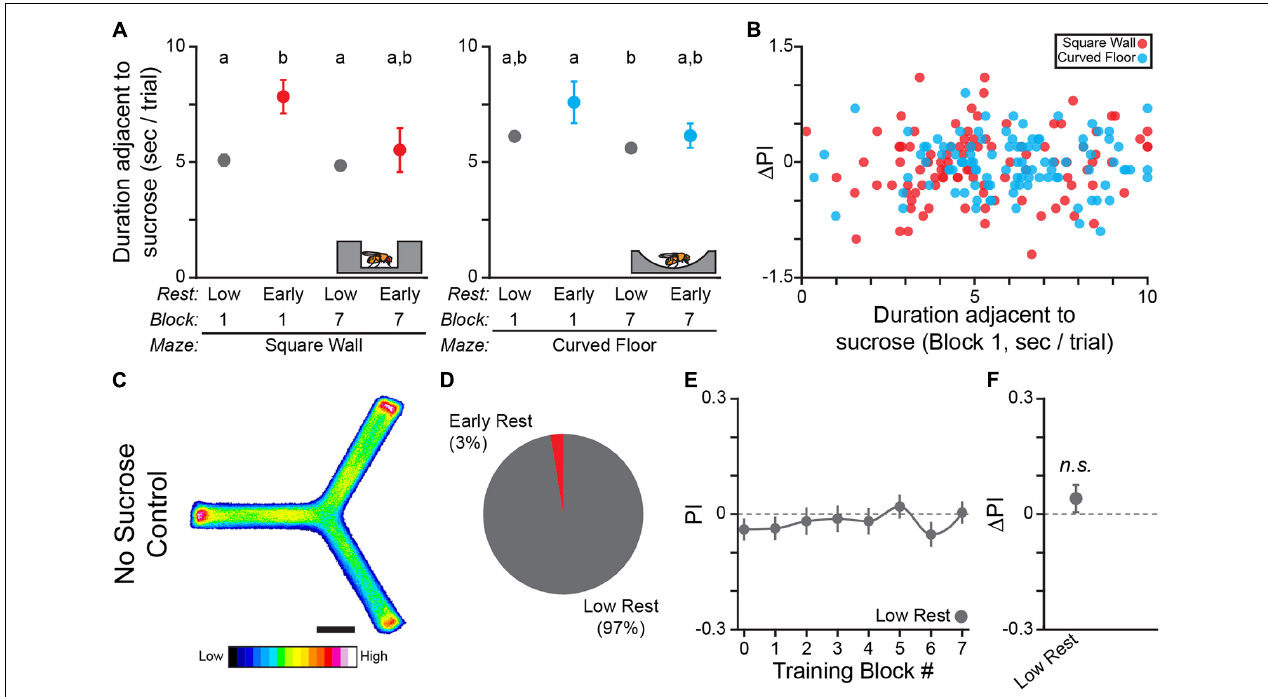
FIGURE 5 | Sucrose promotes rest and is the learning-relevant US in the Y-track. (A) Mean time per trial WT flies spend adjacent to sucrose in the square wall and curved floor experiments. Time per trial is capped at 10 s, because sucrose is automatically removed 10 s after it is made available. Groups with the same letter are not significantly different from one another. (B) Scatter plot of change in turn preference index ( (cid:49) PI) between training block #1 and #7 by time adjacent to sucrose in training block #1 for flies in the square wall experiment (red dots) and curved floor experiment (cyan dots). (C–F) Results of Y-Maze training with no sucrose available. (C) Position heatmaps of trained flies. Scale bar is 5 mm. Color shows relative occupancy of each pixel from low to high. (D) Percentage flies with each rest phenotype. PI by training block (E) and mean (cid:49) PI (F) for low rest flies. Only 2 flies had early rest, which is insufficient to calculate a standard error, so these flies are not plotted. Error bars are standard error of the mean, n.s. : groups are not significantly greater than zero.